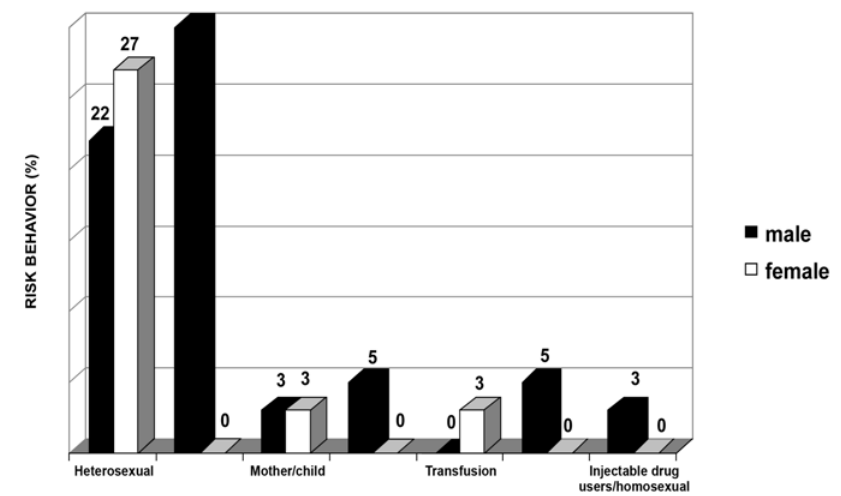
FIGURE 1- Risk behavior (%) of patients with oral lesions